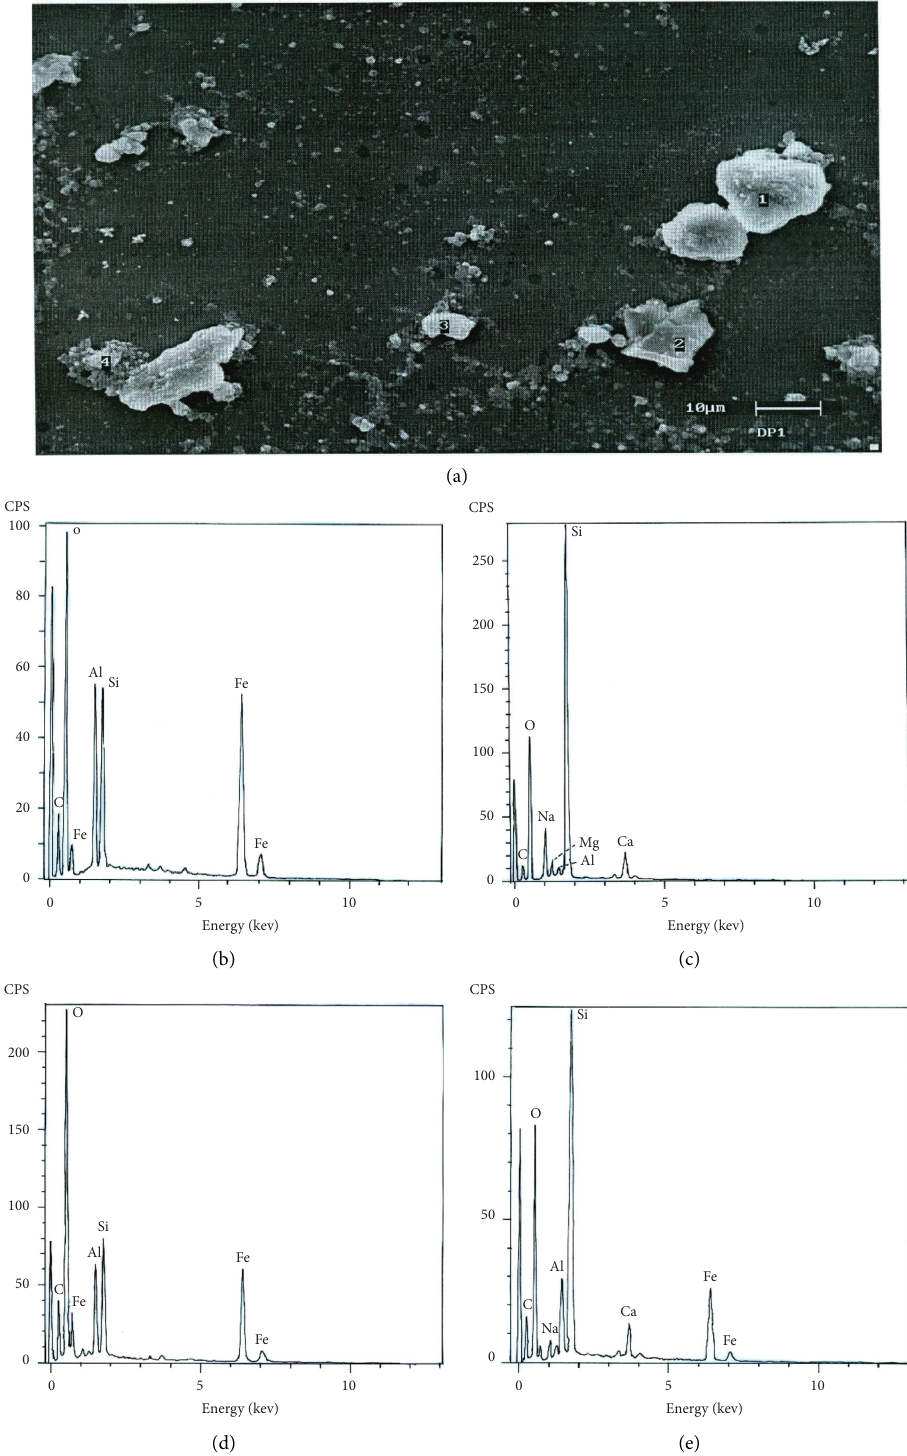
Figure 13: SEM snapshot of DPAD200 (a) and the corresponding EDX (s) of particles 1, 2, 3, and 4 are shown in (b), (c), (d), and (e),